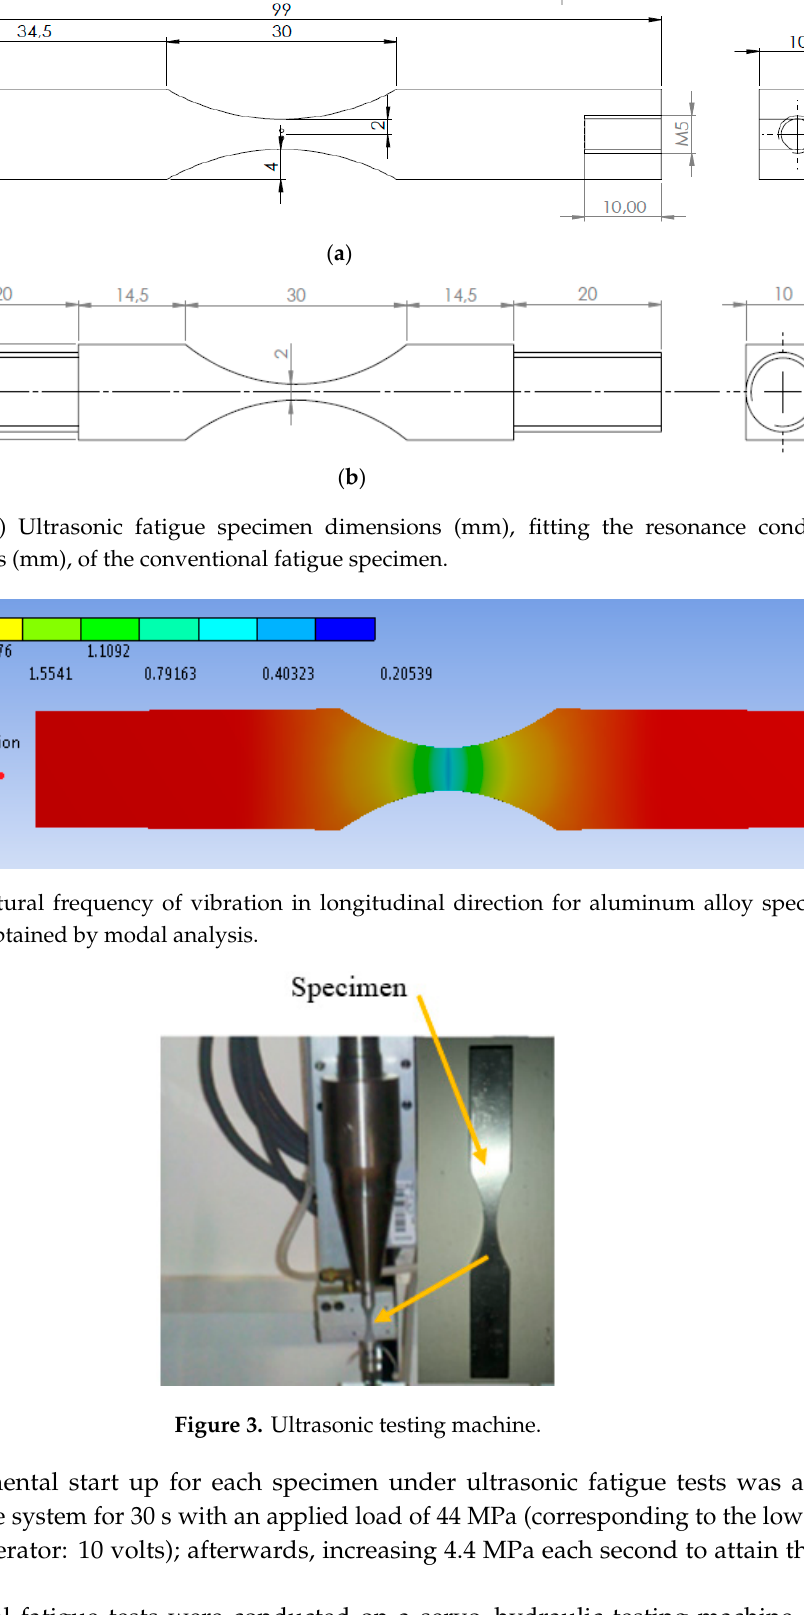
Figure 3. Ultrasonic testing machine.